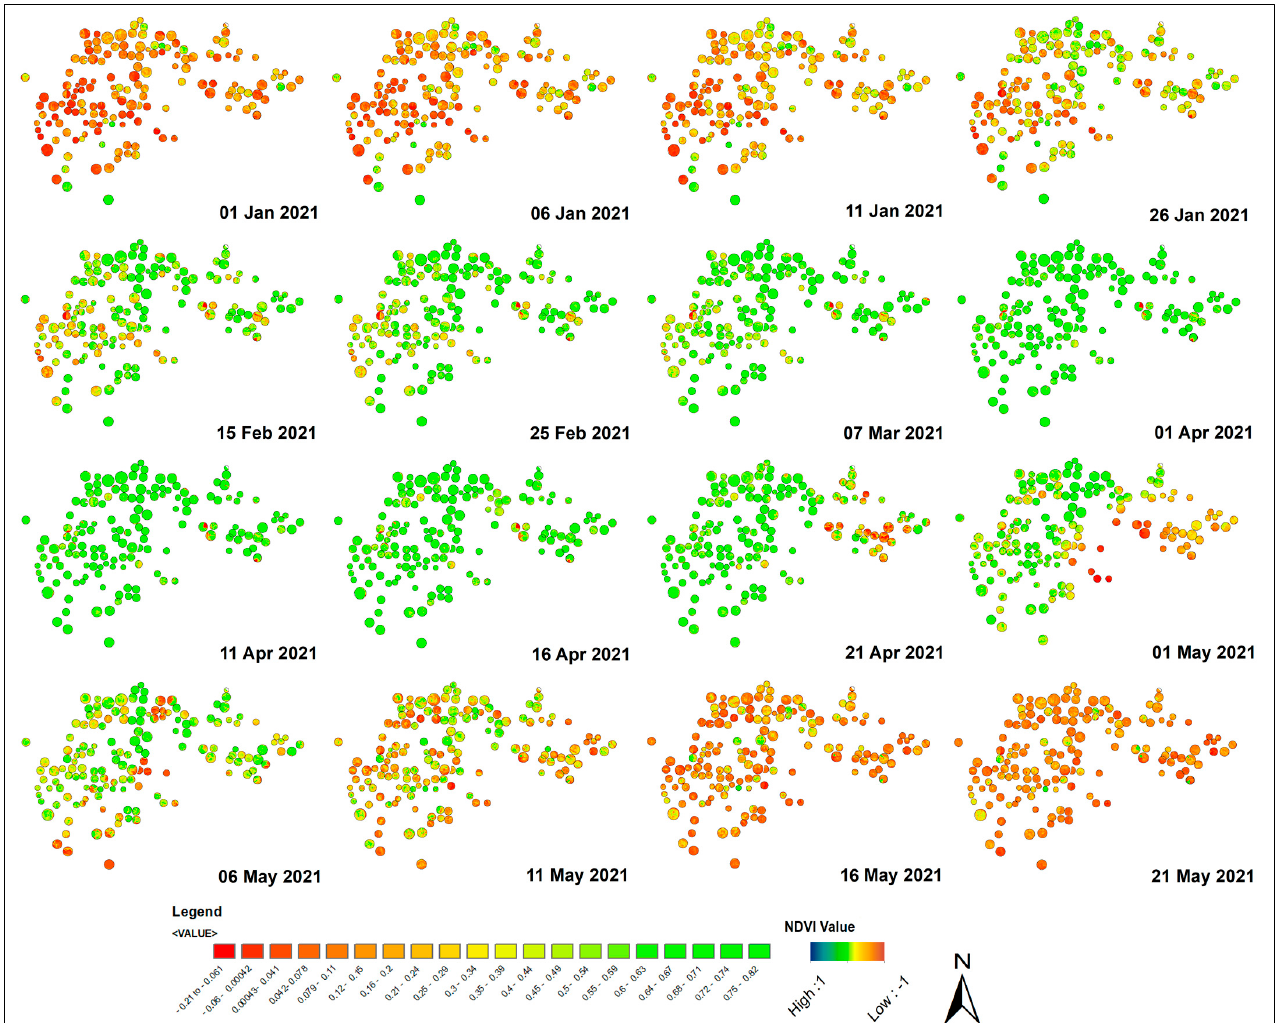
Figure 7. Temporal Variation of the NDVI Value of Centre pivot fi elds in 2021.